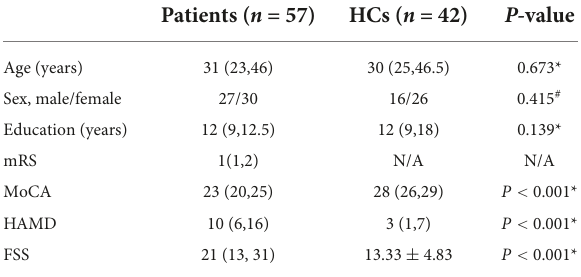
TABLE 1 Demographics information and clinical scales of the